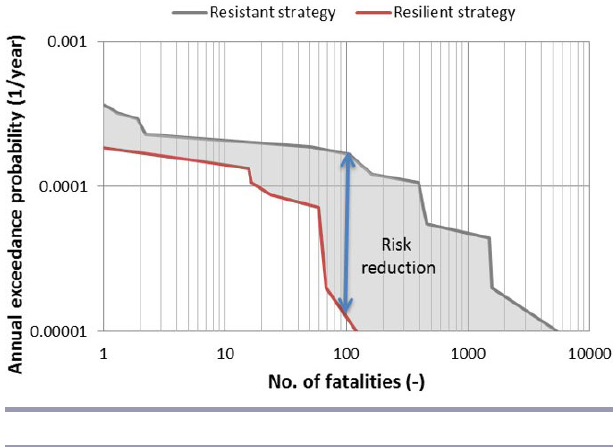
Fig. 4 . Societal risk for resilient strategy (red line) and the resistant strategy (grey line).